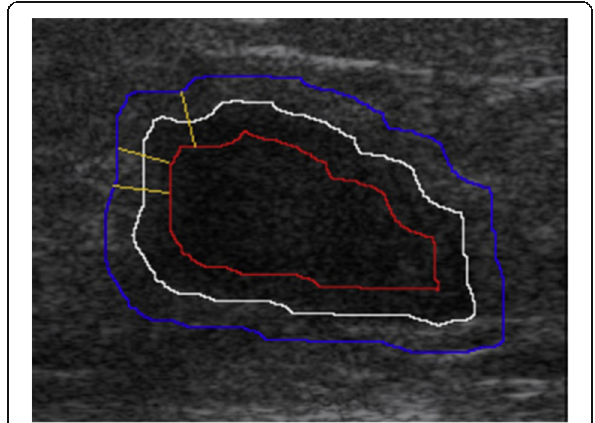
contour (blue) of a